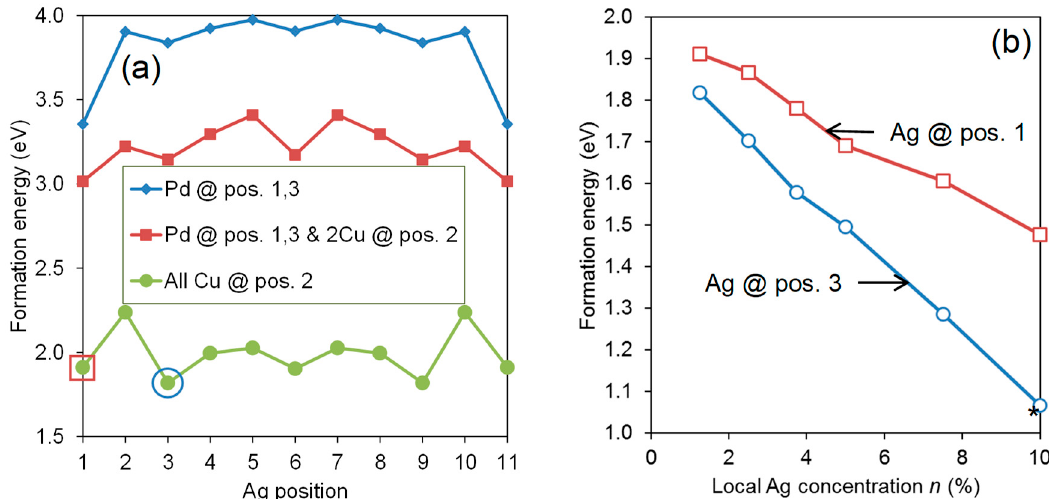
Figure 8. ( a ) The formation energy (defined in Equation (5)) of three fully relaxed ∑ 5(210) Pd 64 Cu 16 models with Ag substituted at the sites defined in Figure 7c. One model was created from the periodic Pd 60 Cu 20 model by substituting Pd for Cu at the positions 1, 3, 9, and 11 (blue line with diamonds), one had in addition moved two Cu atoms to positions 2 and 10 (red line with squares), and one had all Cu atoms located at positions 2 and 10 (green line with circles). The latter corresponds to the model shown in Figure 7c. The two most stable models from ( a ) were used to plot the formation energy as a function of local Ag concentration n in ( b ); Ag was then placed at position 1 (red circles) and position 3 (blue circles). The most stable model with n = 10% is shown in Figure 9b.